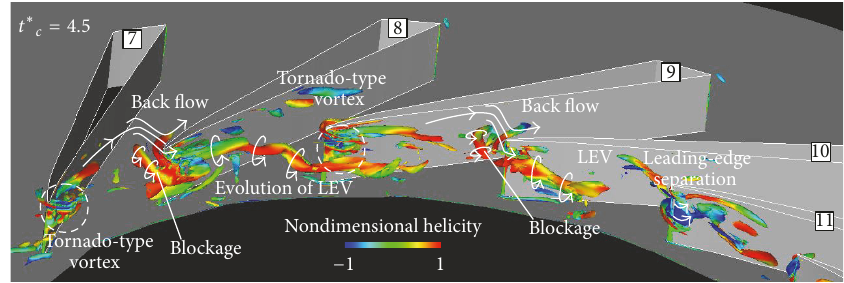
Figure 9: Instantaneous vortical structure of diffuser stall within diffuser passages number 7 to number 11.